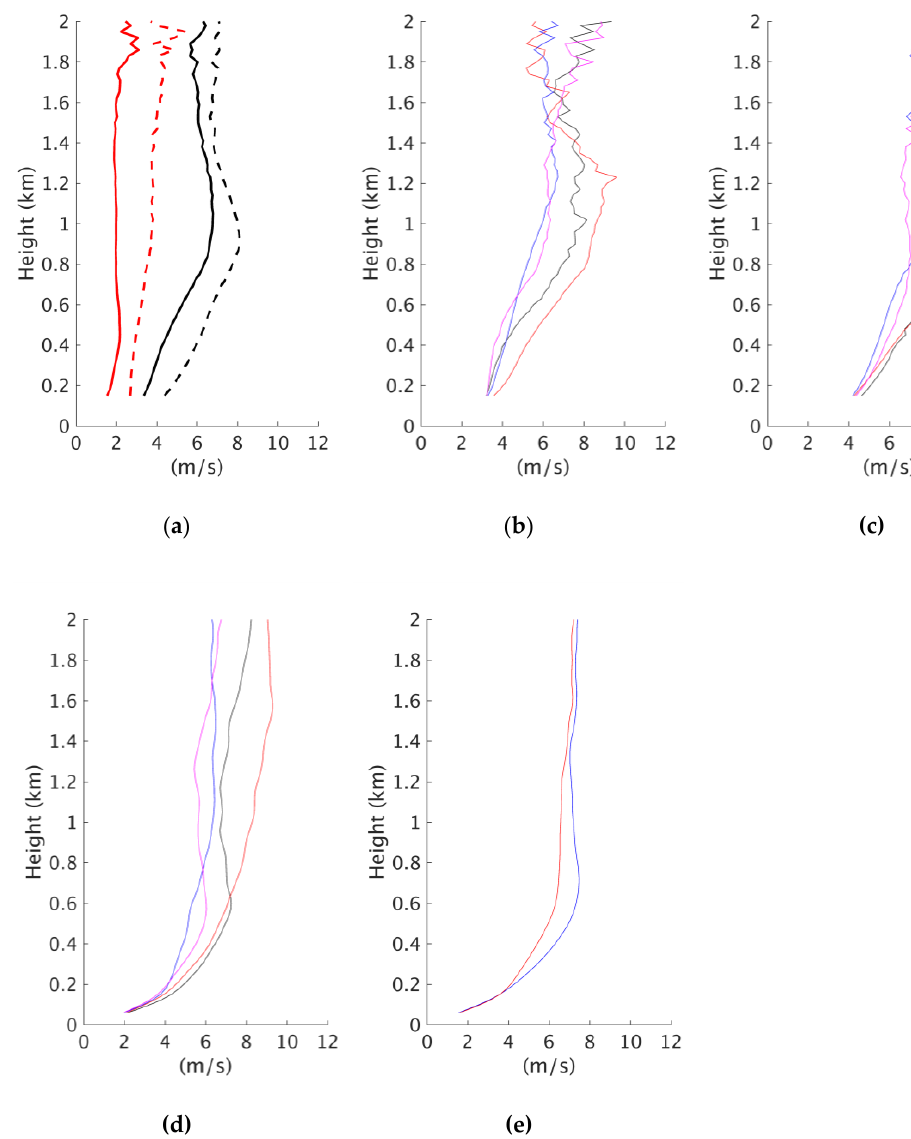
Figure 4. ( a ) Annual (black) and HPE (red) vertical profiles of horizontal wind speed (m / s) at CUHK Figure 4. (a) Annual (black) and HPE (red) vertical profiles of horizontal wind speed (m/s) at CUHK (solid) and KP (dashed) sites. Seasonal vertical profiles at ( b ) CUHK and ( c ) KP derived from LiDAR (solid) and KP (dashed) sites. Seasonal vertical profiles at (b) CUHK and (c) KP derived from LiDAR data. ( d ) Seasonal and ( e ) annual vertical profiles of horizontal wind speed (m / s) based on the upper data. (d) Seasonal and (e) annual vertical profiles of horizontal wind speed (m/s) based on the upper air sounding data collected at 08:00 (HKT) and 20:00 (HKT) every day. For ( b – d ): spring (black), air sounding data collected at 08:00 (HKT) and 20:00 (HKT) every day. For (b-d): spring (black), summer (red), fall (blue), and winter (magenta). For ( e ): 08:00 (HKT) (blue) and 20:00 (HKT) summer (red), fall (blue), and winter (magenta). For (e): 08:00 (HKT) (blue) and 20:00 (HKT) (red).